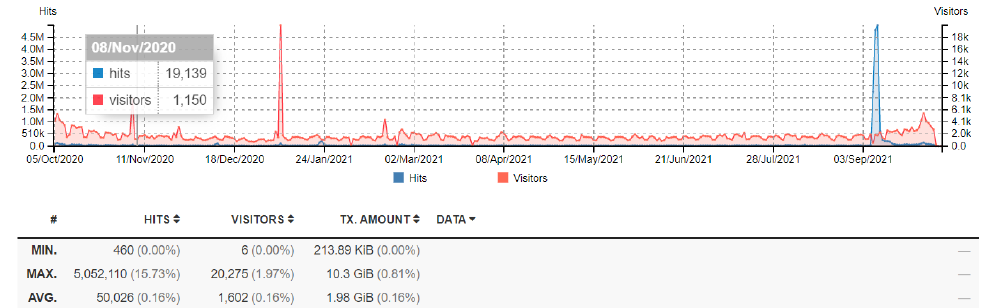
Figure 16. Institutional website hits—September